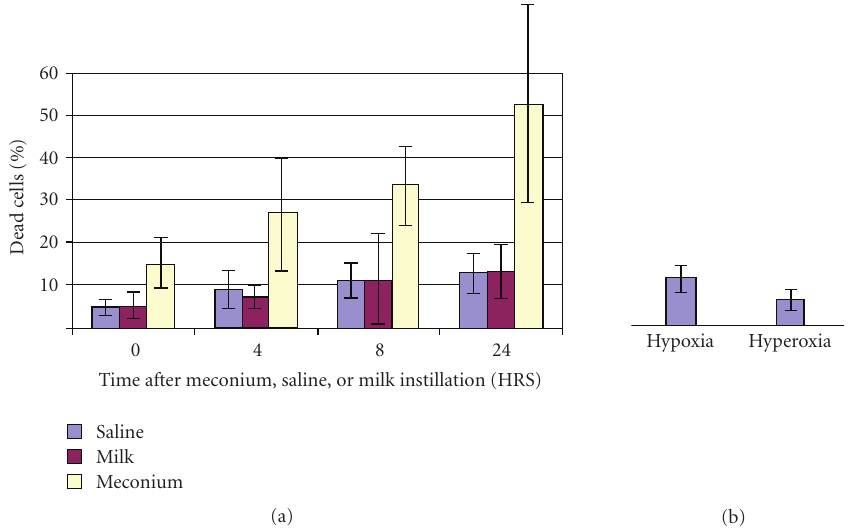
Figure 1: Cell death in groups of animals instilled with saline, milk and 10% meconium. (a) shows percent of dead cells at di ff erent time periods after instillation. The number of dead cells after meconium instillation was significantly higher than after saline and milk instillation at all time periods studied ( P < . 05). (b) shows lavage cell death in animals treated with hypoxia or hyperoxia. There was no statistical di ff erence in the percent of dead cells between hypoxic or hyperoxic conditions. These numbers were negligibly small and comparable to saline-instilled animals.